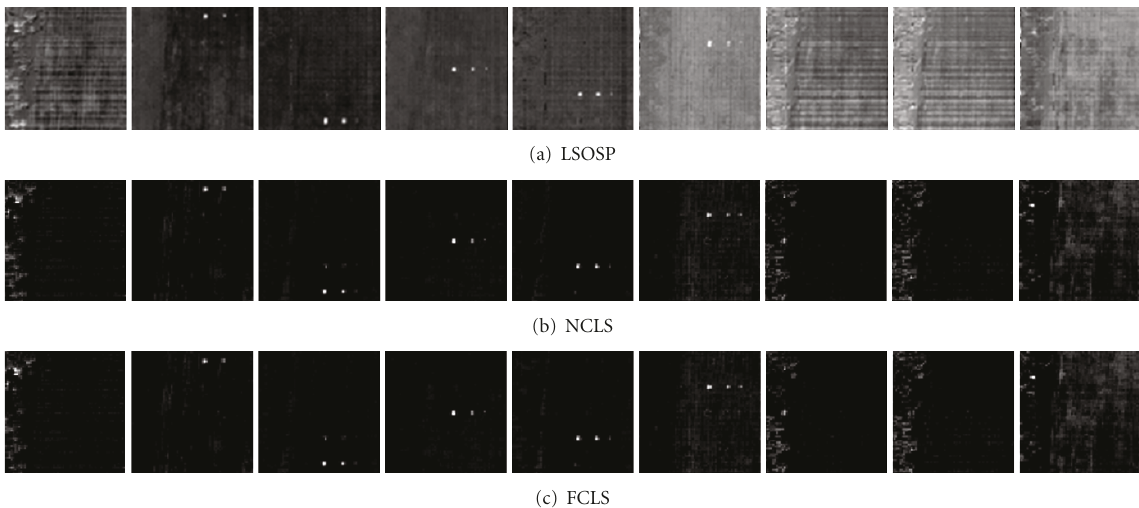
Figure 25: 9 target classes obtained by LSOSP, NCLS, and FCLS using the target pixels generated by UFCLS-USTFA.